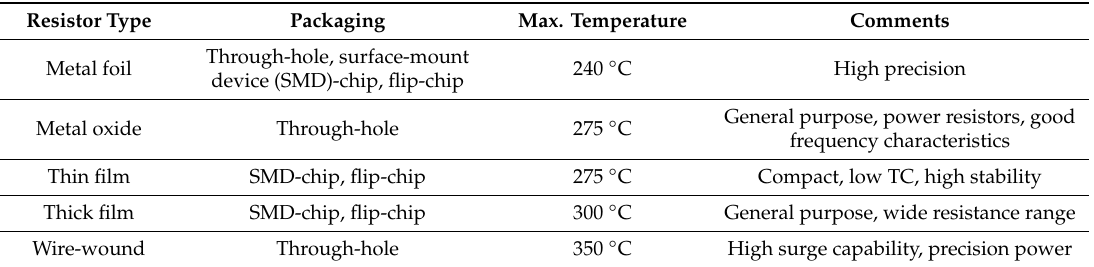
Table 7. Commercially manufactured resistors for high-temperature